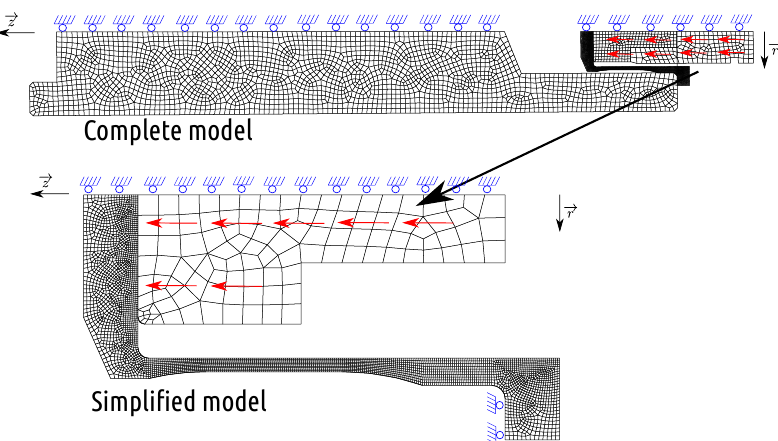
Figure 14. Complete and simplified dynamic tensile